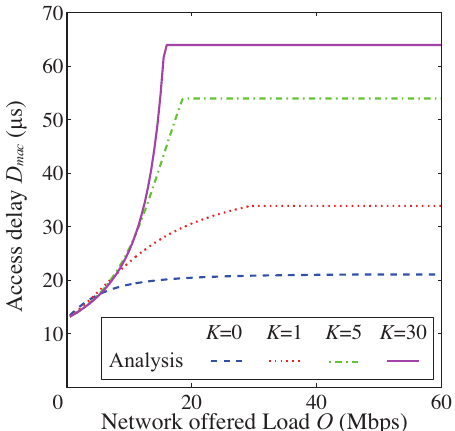
Figure 13. Access delay as a function of offered load for N = 5 and K = 0,1,5, and 30.